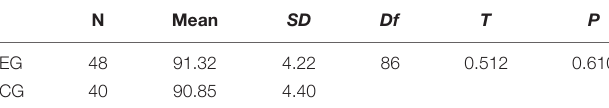
TABLE 2 | Independent samples t -test of midterm test scores of the two